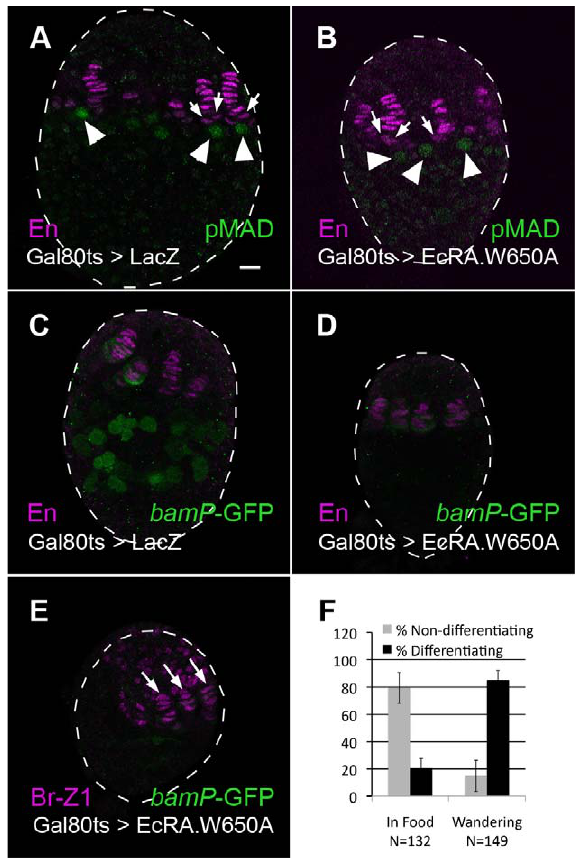
Figure 7. Distinct ecdysone-mediated events are required for niche formation and for PGC differentiation. (A–D) Niche cells are labeled with Anti-En (magenta). (A, B) PGCs containing pMAD (anti- pMAD, green, arrowheads) can be seen in both control and EcRA.W650A ovaries, close to newly formed cap cells (arrows). (C, D) Differentiating PGCs express bamP -GFP (anti-GFP, green). (C) In wild- type LL3 ovaries, PGCs that are not associated with niches differentiate and express bamP -GFP normally. (D) When ecdysone signaling is blocked by expression of EcRA.W650A after niches form, but prior to PGC differentiation, PGCs fail to differentiate despite normal TF formation. No GFP expression in PGCs is observed. Faint, non-specific, GFP can be observed in a few TF cells in both control and experimental ovaries. (E) Br-Z1 (anti Br-Z1, magenta) is expressed in formed niches of EcRA.W650A temperature-shifted ovaries (arrows), but is not expressed in ICs. Bar in (A) (for A–E) is 10 m m. (F) 0–4 h prior to wandering behavior (in food), most ovaries do not carry differentiating PGCs (light bars), while 0–4 h following the initiation of wandering, most ovaries carry differentiating PGCs (black